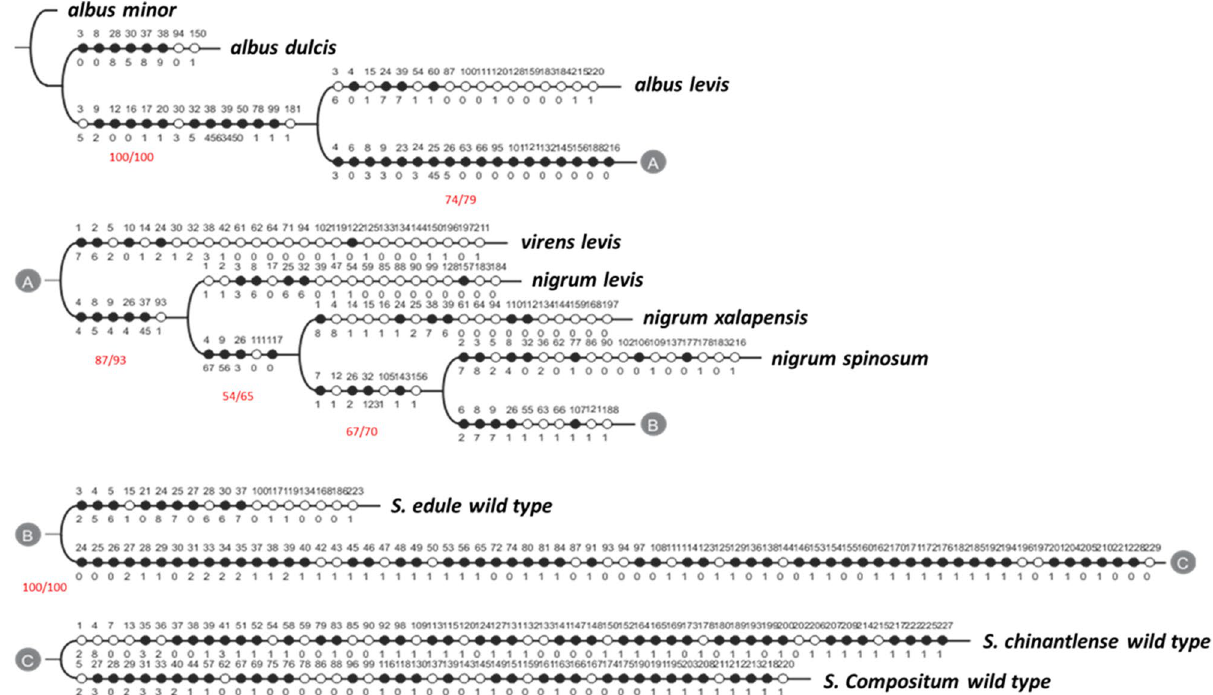
Figure 1. Cladogram of ten genotype of three Sechium spp. based on morphological, biochemical, genetic, and biological activity characters on malignant cell lines to identify the character/genotype. White dots represent apomorphic variation and black dots plesiomorphic. The numbers on the higher and lower parts of the cladogram branch represent the character and the state in which it varies. The values separated by the diagonal line represent the Bootstrap/Jackknife indexes, with L = 566, Ci = 59 and Ri =